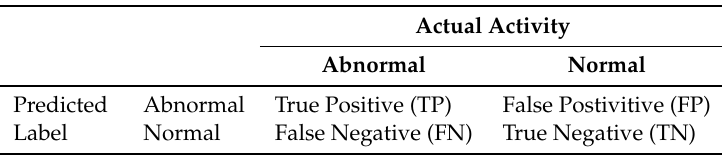
Table 1. Confusion